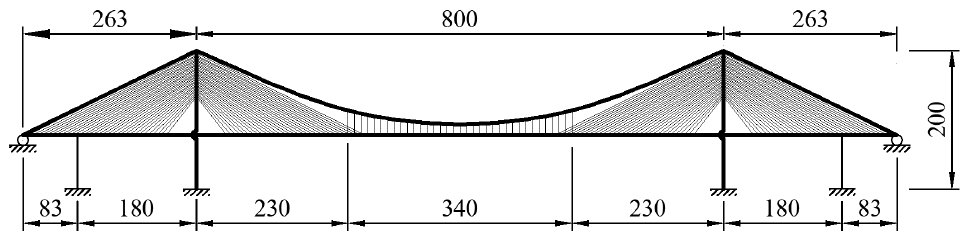
Figure 6. Dimensional properties of the test model of the bridge (unit: m).